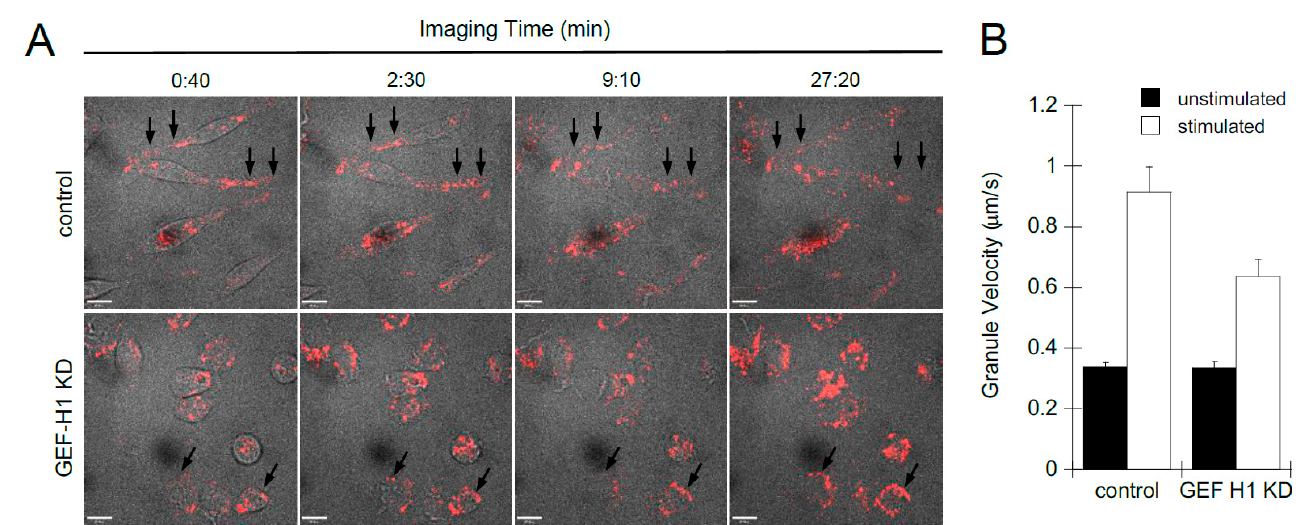
Figure 4. Depletion of GEF-H1 affected cell spreading and granule mobility. Cell morphology transitions and granule mobility were examined by live-cell imaging of RBL-2H3 cells during antigen stimulation. Granules were labeled with LysoTracker Red and cells were stimulated after 1 min of imaging. ( A ) Representative still images of time points from control cells (Video S1) and from GEF- H1-depleted cells (Video S2). Compared to control cells, GEF-H1 KD reduced granule motility and caused their retention adjacent to the plasma membrane ( arrows ). Scale bar = 10 µm. ( B ) Depletion of GEF-H1 resulted in reduced granule velocity. Granule velocity was measured using Volocity v6.3 software ( n ≥ 37 granules tracked from two independent videos for each strain). Supplementary videos showing live-cell imaging of LysoTracker Red are available at the following direct object identifiers: Video S1: LysoTracker Red live-cell imaging of stimulated RBL-2H3 cells, control https://doi.org/10.6084/m9.figshare.21454665 and Video S2: LysoTracker Red live-cell imaging of stimulated RBL-2H3 cells, GEF-H1 knockdown https://doi.org/10.6084/m9.figshare.21454869.